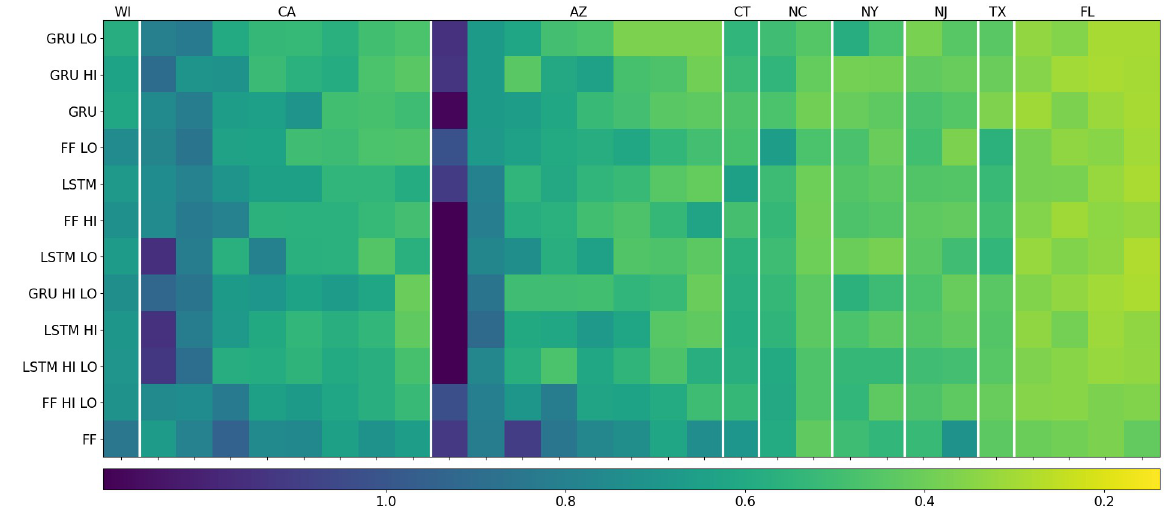
Fig 8. Combined scores on testing locations (see S3 Appendix for metric definition). The rows represent the models and are organized bottom to top from highest score (worst model) to lowest score (best model). The columns represent individual locations (see Table B in S7 Appendix for the names), and the vertical, white lines separate states. The states are organized left to right from highest mean score to lowest, and within each state the locations are organized left to right by descending